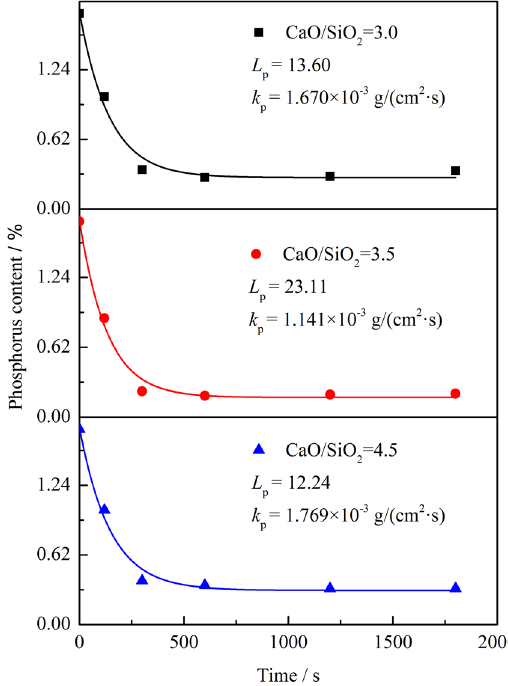
Figure 1: Fitting curves of the P content of the fi nal iron sample as a function of time with the basicity ranging from 3.0 to